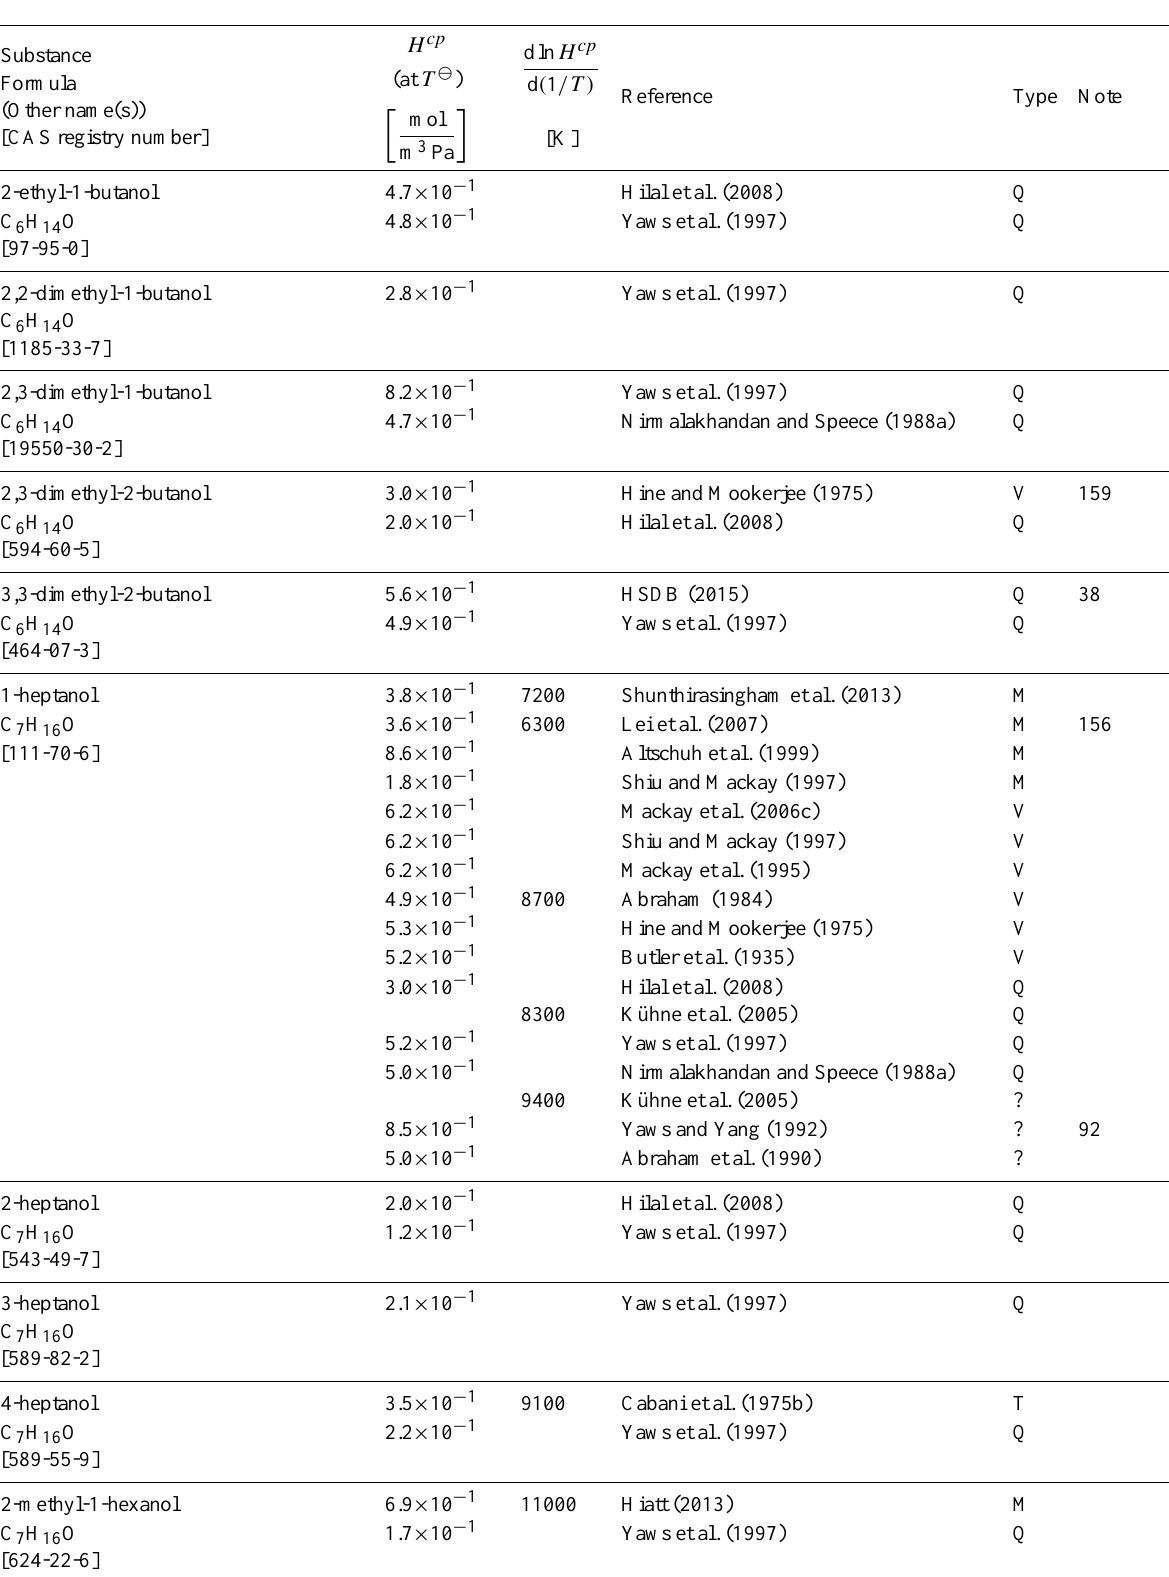
Table 6: Henry’s law constants for water as solvent